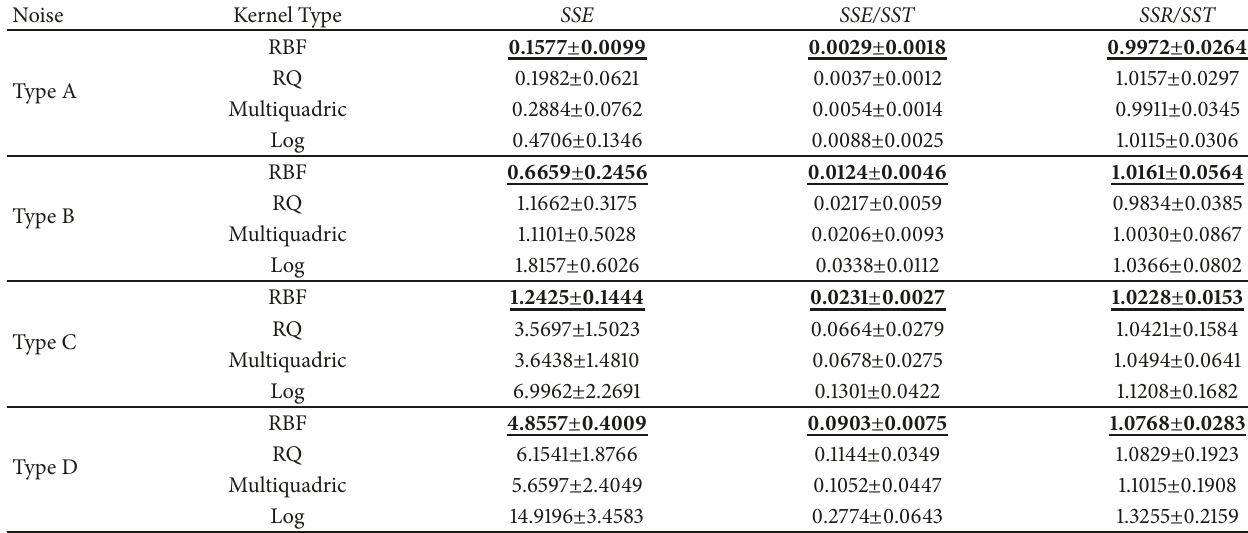
Table 4: . Comparisons of WTWTSVR on Sinc functions with different kernel functions.